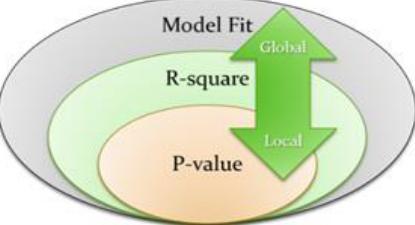
Figure 8. Evaluation criteria for hypothesis testing.